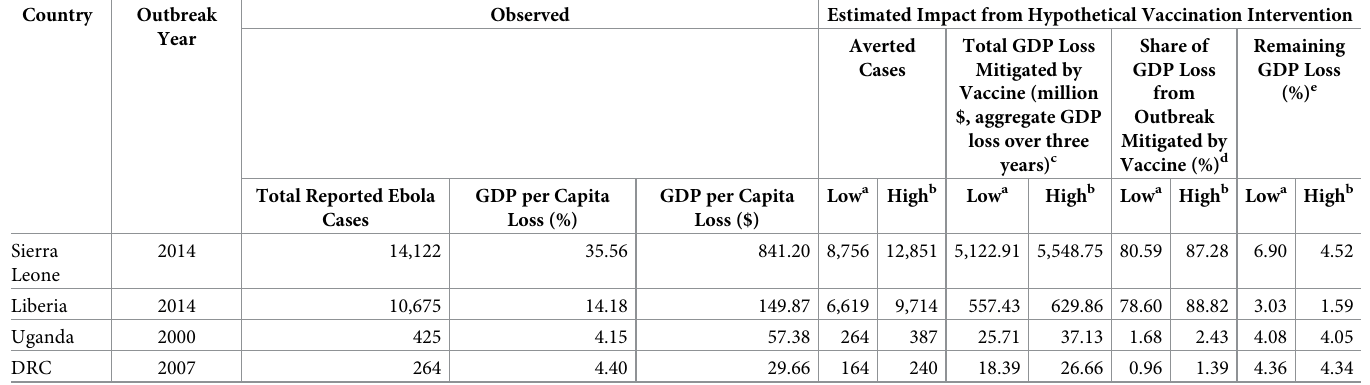
Table 4. Estimated economic benefits of prophylactic Ebola vaccine by year 3 post-outbreak, by country. Country Outbreak